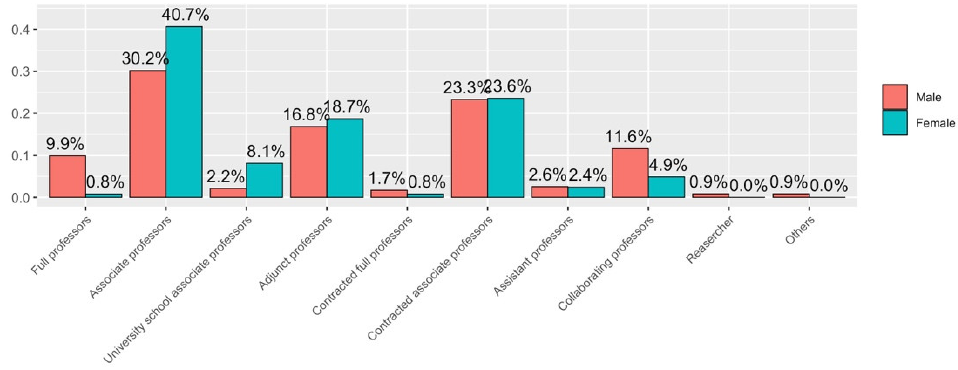
Figure 11. Answers to Q1.c disaggregated by gender.